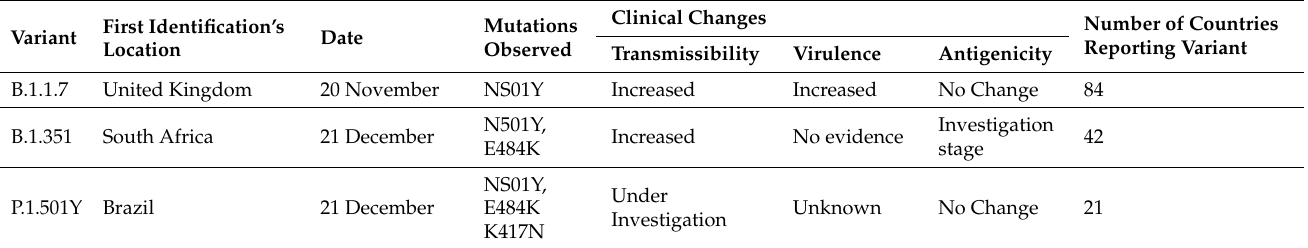
Table 3. Viral Mutations and their prevalence across the globe